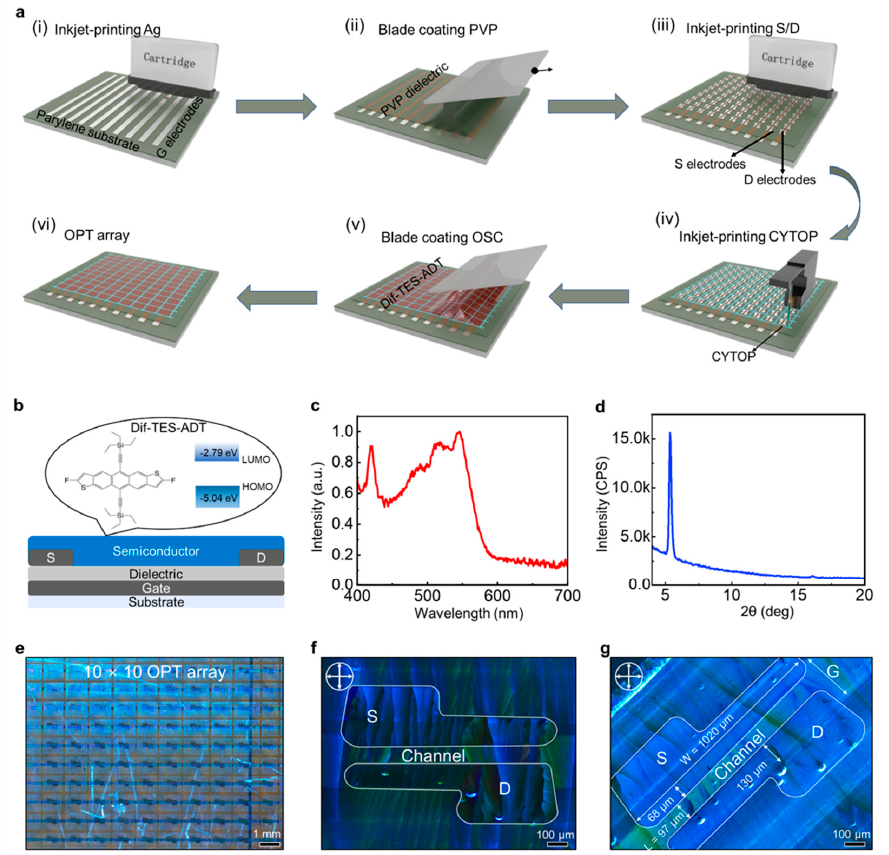
Figure 1. Platform for fabricating the OPT array. ( a ) Schematic illustrating the flow diagram of the proposed fully printed fabrication process. ( a-i ) Inkjet-printing gate electrodes. ( a-ii ) Blade coating PVP dielectric layer. ( a-iii ) Inkjet-printing source/drain electrodes. ( a-iv ) Inkjet-pringting CYTOP lines. ( a-v ) Blade coating organic semiconductor film. ( a-vi ) Obtained OPT array. ( b ) Schematic cross section of the OPT, energy level values, and chemical structure of Dif-TES-ADT. ( c )